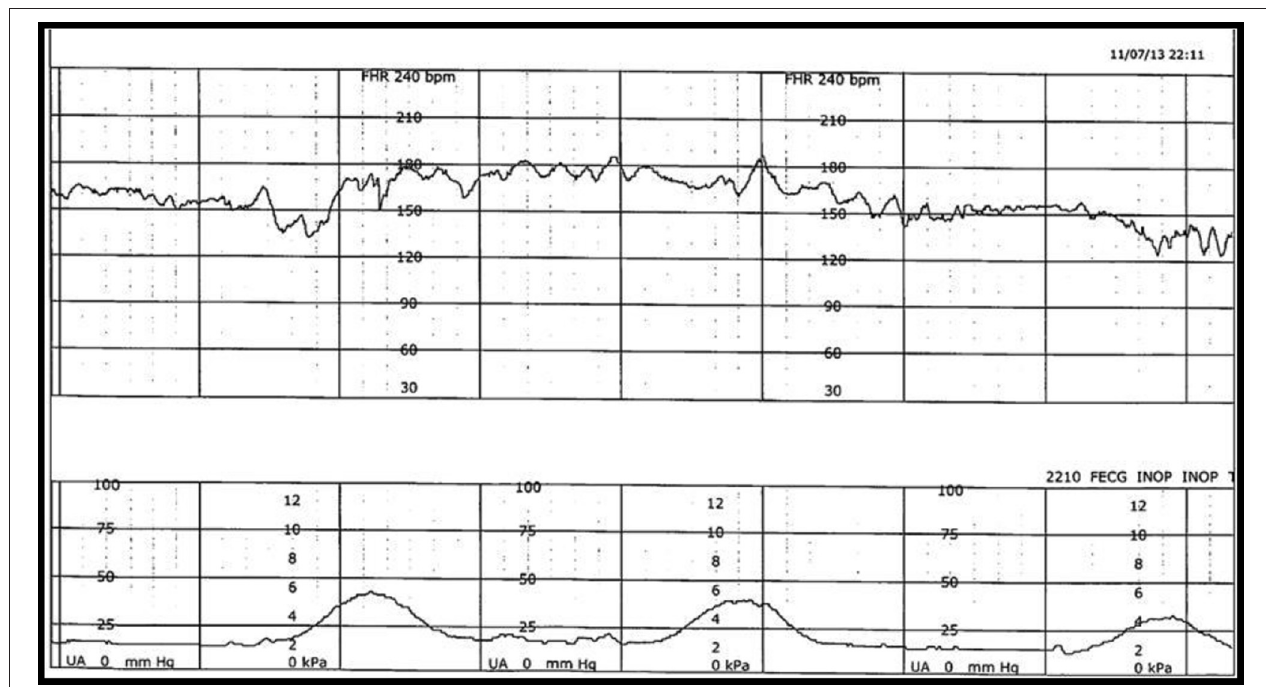
FIGURE 1 | Example of FHR (top) and uterine contraction (bottom) during labor, captured simultaneously and stored electronically in a digital format but available only as a rasterized pdf